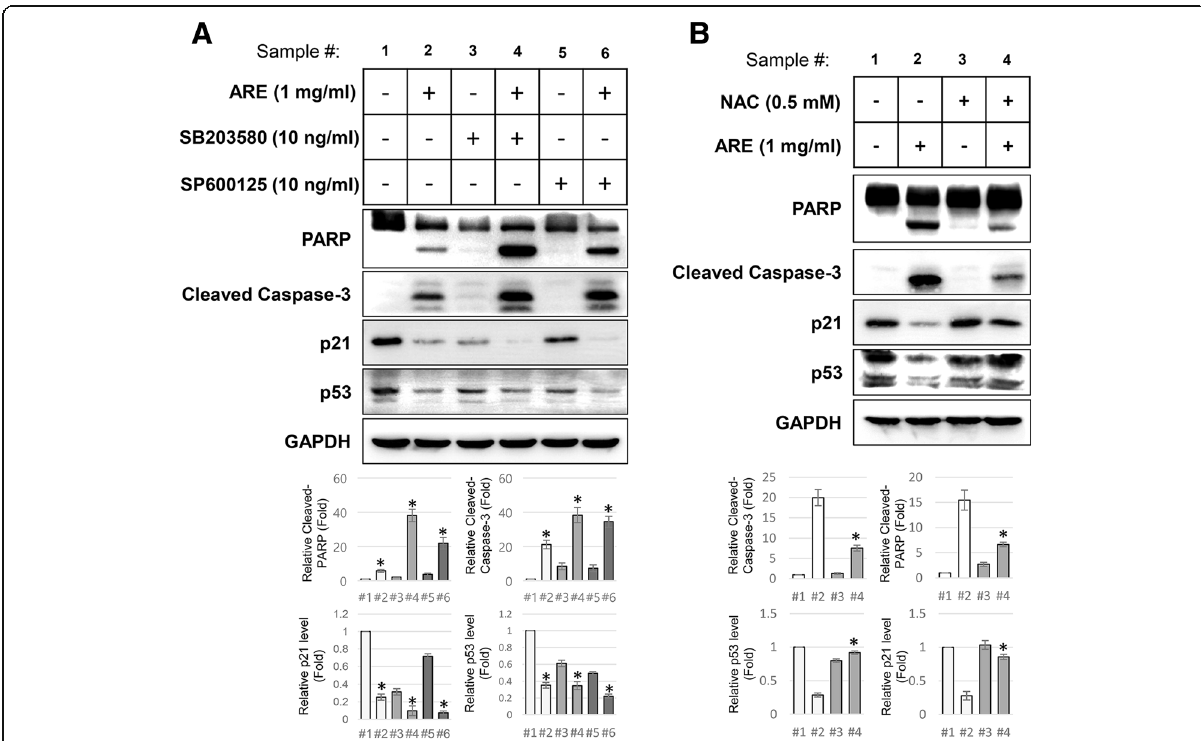
Fig. 5 ROS-dependent ARE-mediated apoptosis and the expression of p53 and p21 proteins in G361 cells. a The effects of specific inhibitors of JNK (SP600125, 10ng/ml) and p38 (SB203580, 10ng/ml) on ARE-mediated apoptosis and the expression of p53 and p21 proteins were tested using western blotting. The cells were pretreated with the inhibitors for 1h before ARE (1mg/ml, 4h) treatment. The relative density of cleaved caspase-3 and – PARP, along with p21 and p53 were represented as graphs (bottom panel). Data represent the mean±SEM (n=3). The significant changes after ARE treatment were marked as * ( p <0.05) ( b ) The results of western blot analysis showing the effects of an ROS scavenger (NAC, 0.5mM) on ARE- mediated effects in G361 cells are shown. The cells were pretreated with NAC for 1h before ARE treatment. The relative density of each proteins were represented as graphs (bottom panel). Data represent the mean±SEM ( n =3). The significant changes after ARE treatment were marked as * ( p